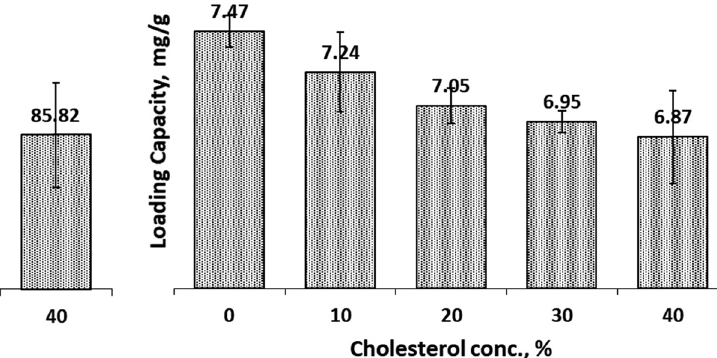
Figure 7: Loading capacity of Cur in cocoliposome in SIF solution as a function of